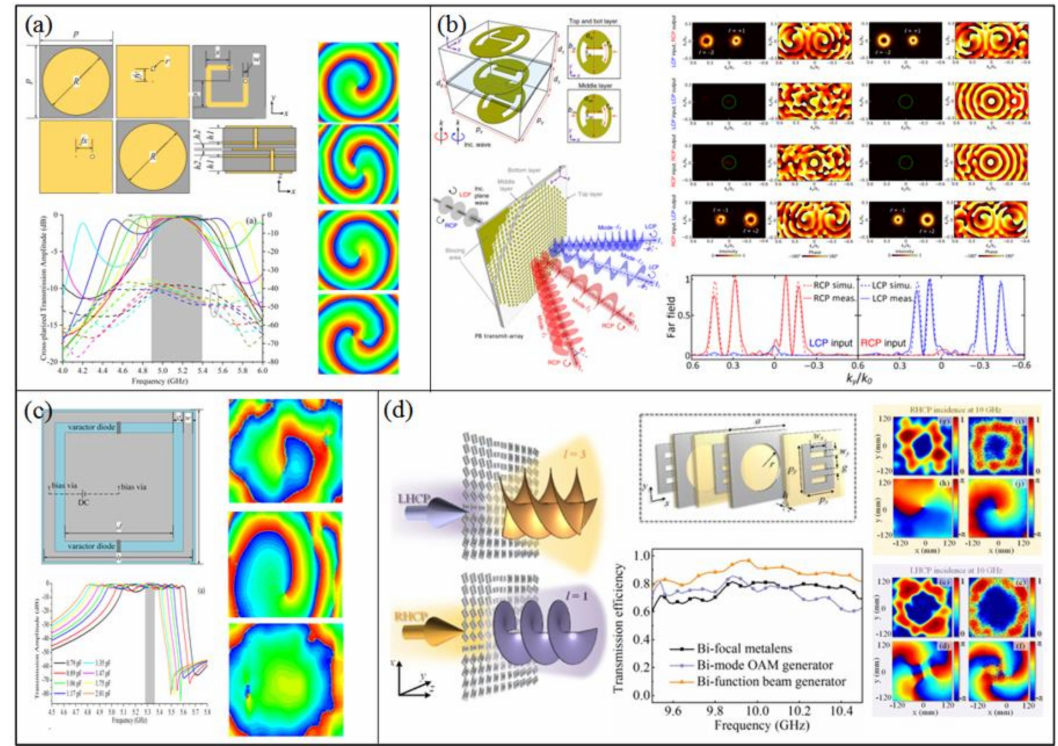
Figure 13. ( a ) OAM metasurfaces based on multi-layer CP conversion unit [77]. ( b ) Vortex beams multiplexing based on CP wave [79]. ( c ) Multiple OAM modes by active metasurface [78]. ( d ) CP wave decoupled OAM metasurface